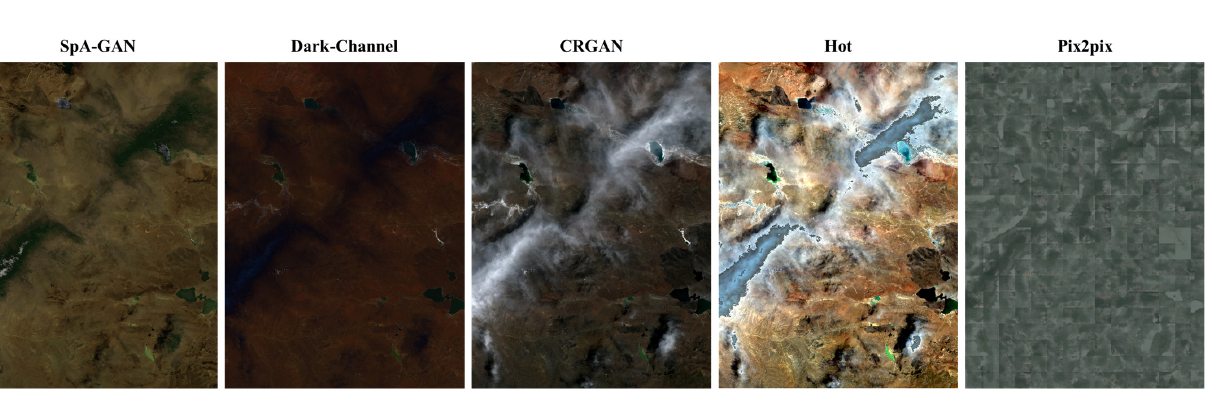
Figure A1. Displays cloud removal results from the comparison method. SpA-GAN and Dark Channel show the absolute luminance value after image rendering.